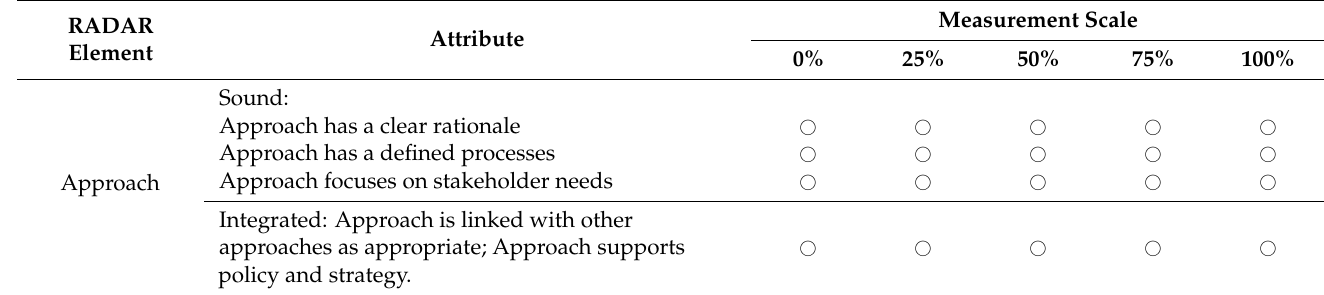
Table A2. RADAR scoring matrix for